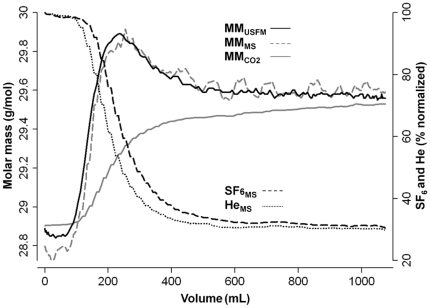
Comparison of single breath washout signals.Typical ultrasonic flowmeter (USFM) and mass spectrometer (MS) signals from a single breath washout (SBW) using sulfur hexafluoride (SF6) and helium (He) in a healthy male adult. USFM derived molar mass (MMUSFM black solid line) and MS derived molar mass (MMMS grey dashed line) reflected changes in SF6 washout relative to He washout measured using MS: SF6MS (black dashed line), and HeMS (black dotted line). The MM signal derived from CO2 (MMCO2 grey solid line) reflected naturally exhaled MM similar to MM signals from pre-test breaths.